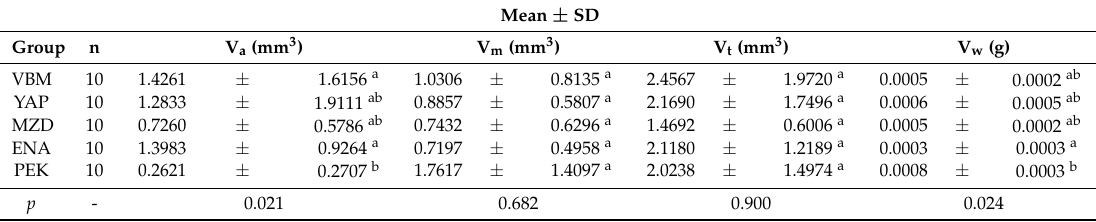
Table 2. Means and standard deviations (SDs) of volumetric losses of antagonists (V a ), materials (V m ), antagonists and materials (V t ), and the weight losses of materials (V w ) after wear. Mean ±